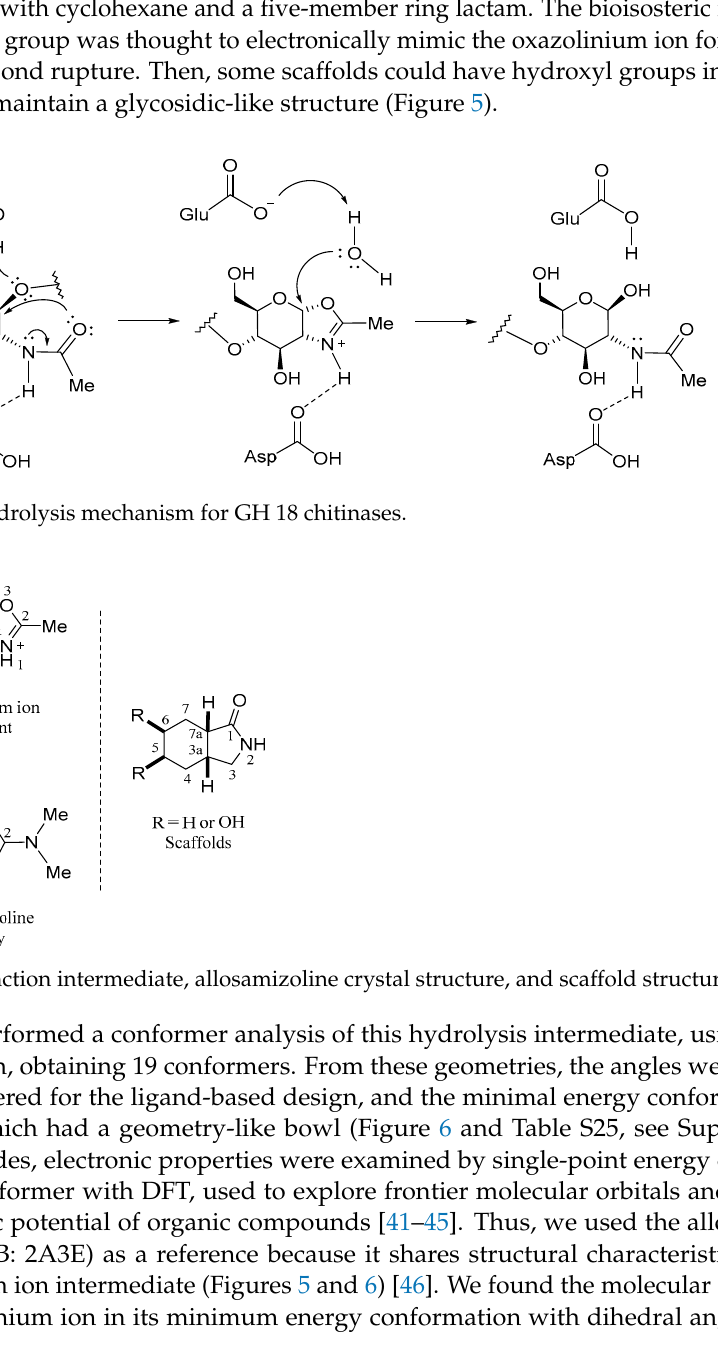
Figure 6. Values for dihedral angles: φ 1 (H-3a-7a-H), φ 2 (C5-O4-C3a-O3) and φ 3 (C6-C7-C7a-N1) for oxazolinium ion minimum energy ( A ), and φ 1 (H-6a-3a-H), φ 2 (C5-C6-C6a-O1) and φ 3 (C5-C4-C3a- N3) for allosamizoline crystal moiety ( B , PDB: 2A3E) and θ fused ring angles. On the other side, scaffold design was performed on the basis of reliable synthetic methods, like those described in Meyers’s lactams synthesis for the preparation of cis - and trans -fused lactams [47–49]. As a result, from conformational analysis in comparison to oxazolinium ion and allosamizoline moiety, only in Figure 7, the cis -fused scaffolds and their enantiomers had similar angles (Table S26, see Supplementary Data). Geometry gets closer to the oxazolinium ion because scaffolds and intermediates had six-five fused rings and allosamizoline had a five-five fused system. Further, φ 1 , θ 1 , and θ 2 angles indicate similar amide orientation in scaffolds, as oxazole shows in the structure references.